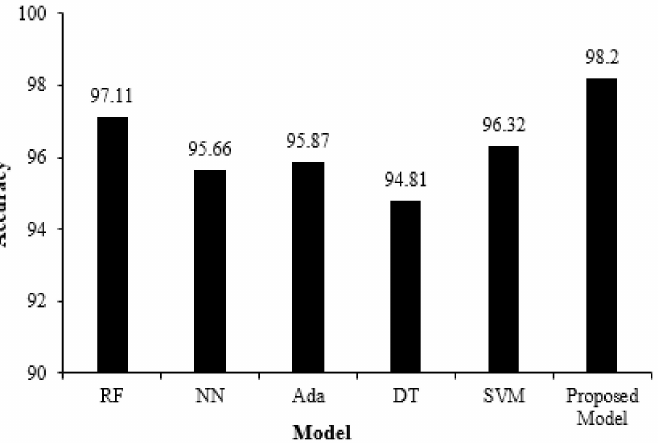
Figure 5. Performance comparison bar chart of individual and proposed ensemble